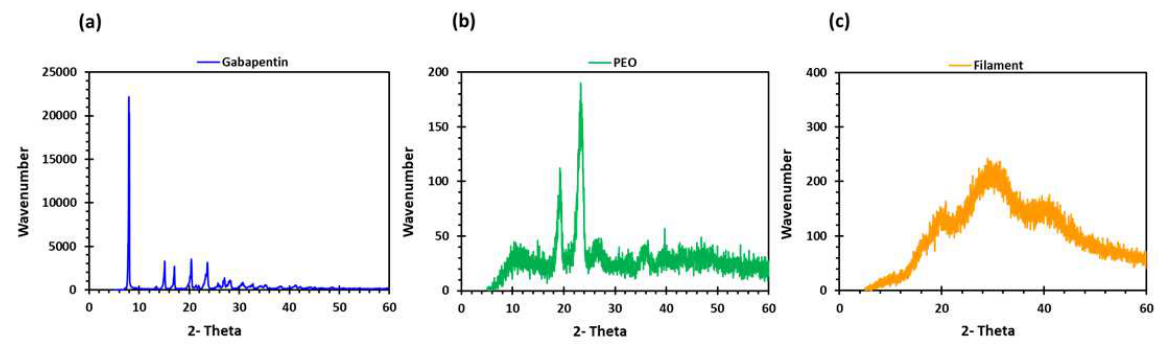
Figure 4. XRD profiles of ( a ) gabapentin; ( b ) polyethylene oxide (PEO); and ( c ) GBP/PEO filament. Table 1. Drug loading and three-point bending results of filaments ( n = 10, standard deviations are in parenthesis).